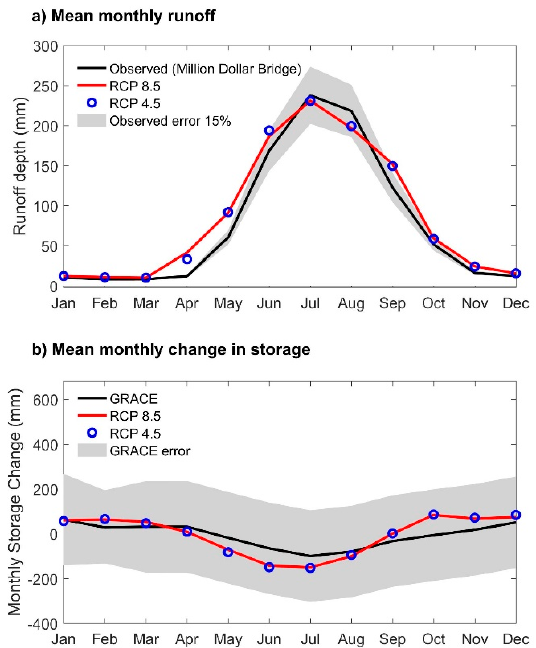
Figure 3. Evaluation of model performance, using mean monthly data for the period 2006–2016, was performed by comparing simulated output from MM45 and MM85 with: ( a ) runoff at the watershed outlet; and ( b ) TWS change based on GRACE satellite data. USGS estimates of stream gauge error (15%, see Table 1) are illustrated by gray shading in Figure 3a. Error in GRACE estimates (illustrated by gray shading in Figure 3b) accompanied the data provided by the University of Colorado GRACE Data Portal (listed in Table 1). The reported error associated with individual monthly estimates of total water storage was doubled because the change in monthly storage was calculated for illustration in Figure 3b.